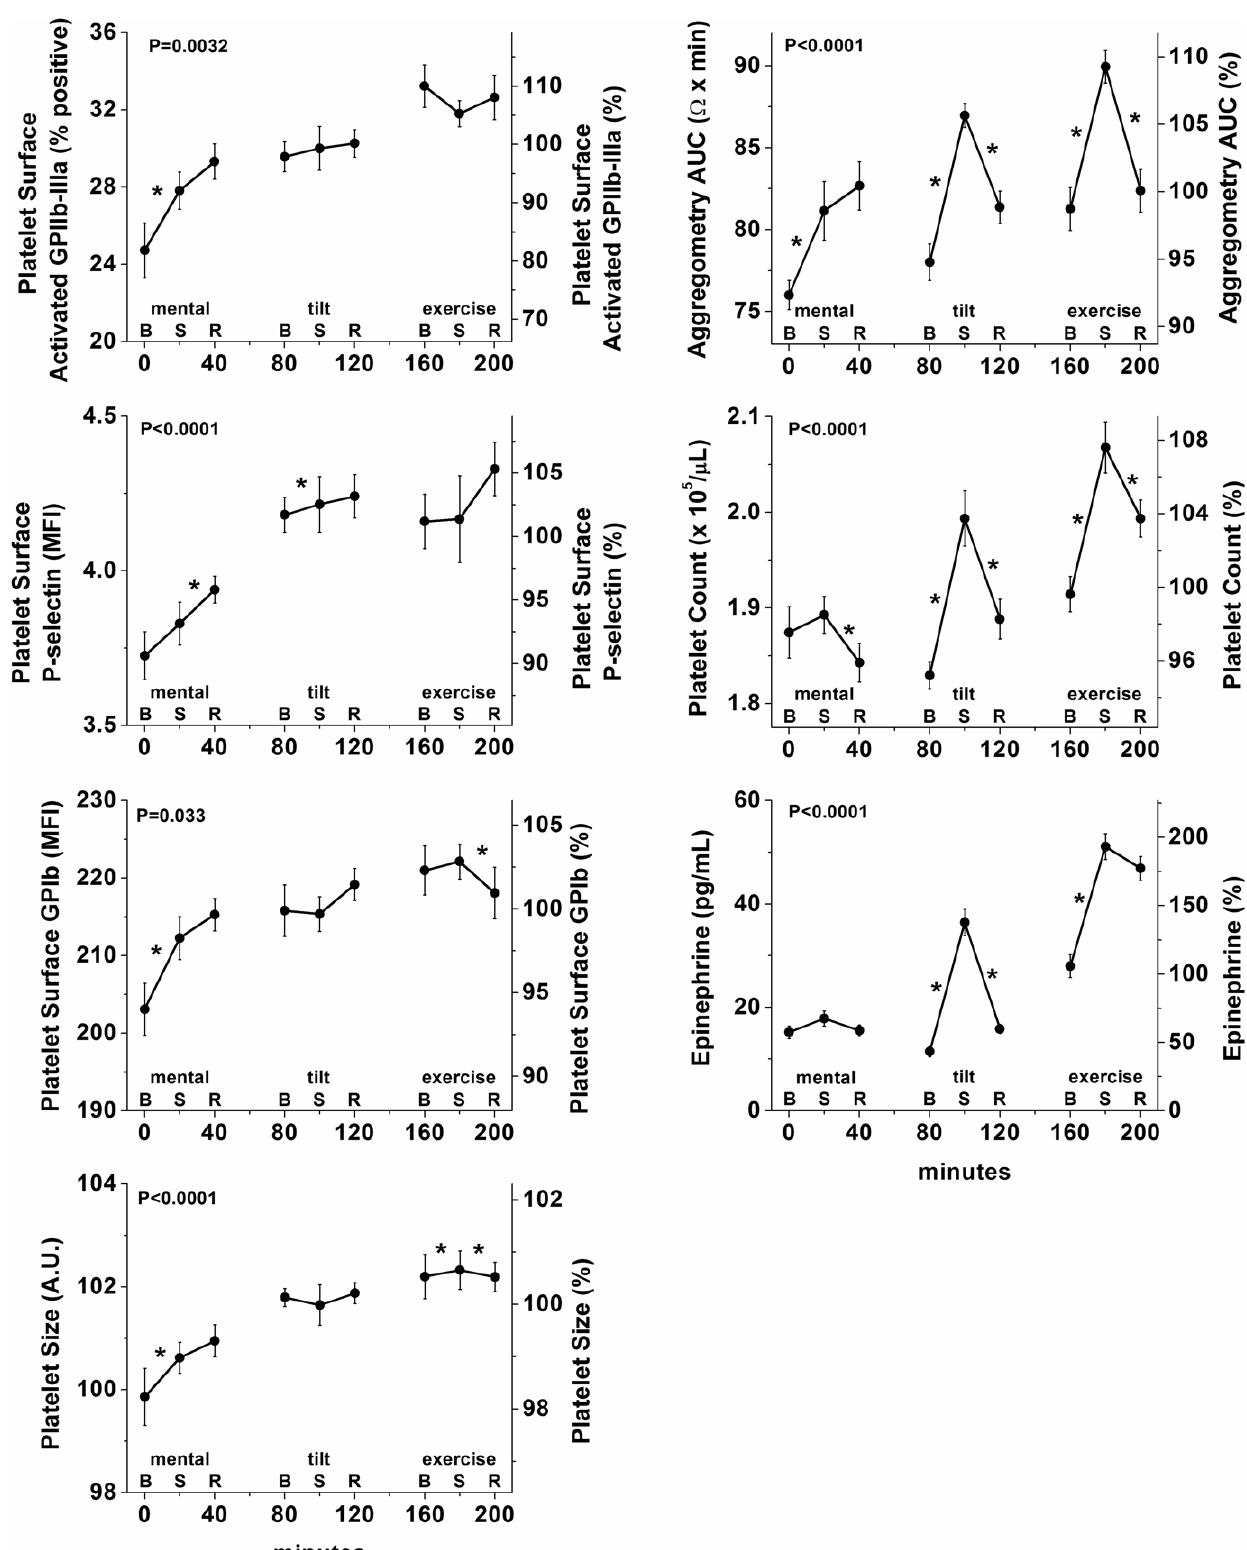
Figure 3. Independent influence of behavioral stressors on platelet function. WBA, platelet count, and plasma epinephrine were increased by each of the three stressors, with a (partial) recovery during recovery. In contrast, while the platelet surface markers showed a gradual increase across the approximately 3-h test battery, there was no consistent increase and recovery caused by the three stressors. Mental, mental stress test; tilt, passive head up tilt table test; exercise, cycle exercise test; B, baseline; S, stress test; R, recovery; x-axes, minutes from first blood sample within test